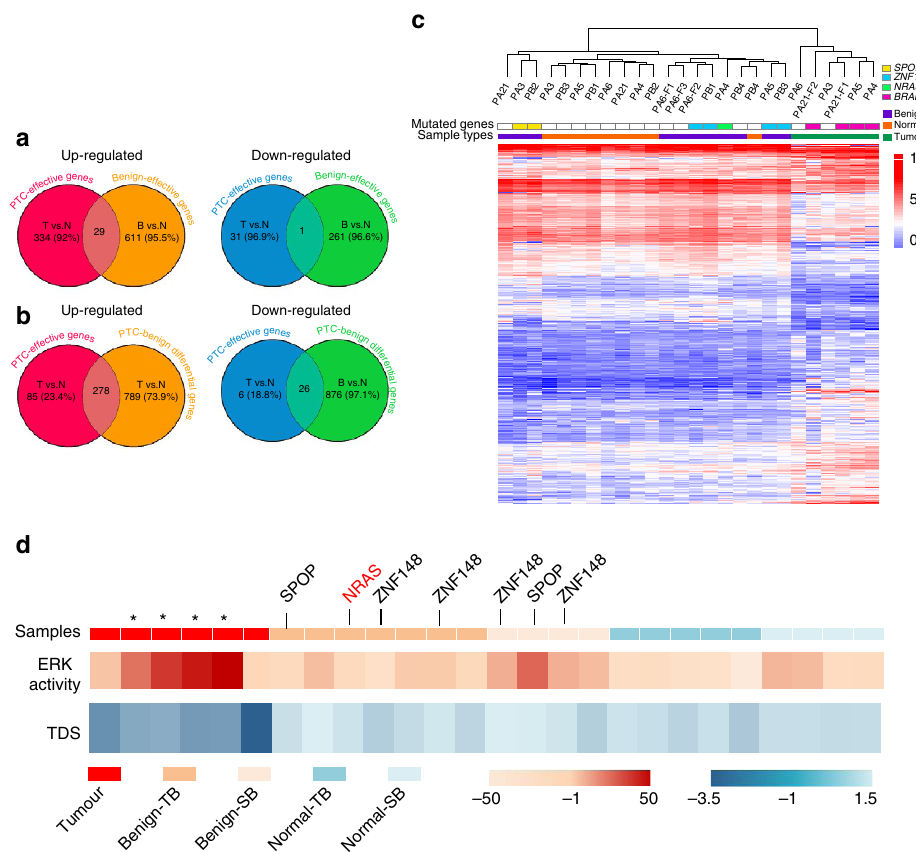
Figure 4 | Transcriptional patterns defining malignant and benign thyroid tissues. ( a ) Venn diagrams showing overlaps between PTC-effective and benign nodule-effective genes. T versus N: PTC versus normal tissues (FC 4 1.5); B versus N: benign nodules versus normal tissues; ( b ) Overlap of PTC-effective genes (Tversus N) with genes differentially expressed between PTC tumour and benign nodules (Tversus B). ( c ) Unsupervised hierarchical clustering of transcribed genes (FPKM 4 1) and differentially expressed over 1.5-fold for 26 tissue samples. ( d ) TDS and ERK-activity score. Samples were coloured by tissue types (upper panel). The TDS was based on the expression of 16 genes and the ERK activation by the expression of 52 genes. The asterisk indicates the PTC samples with BRAFV600E mutation, and the key mutations in benign nodules were